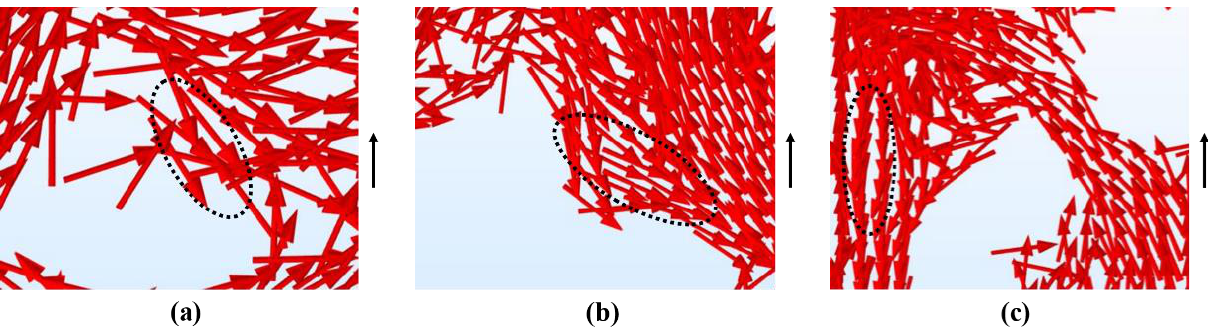
Figure 4. Partial enlarged view of arrow diagrams, ( a ) corresponding to part 1 in Figure 3d, ( b , c ) corresponding to parts 2 and 3 in Figure 3f, respectively.